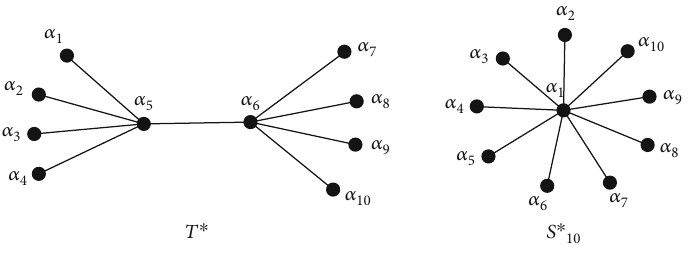
Figure 3: Trees of order 10 :